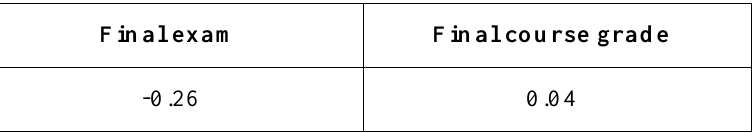
Estimation of the Effect of Using the Khan Academy Collection 2 Versus Traditional Resources (Scenario 2) Final exam Final course grade -0.26